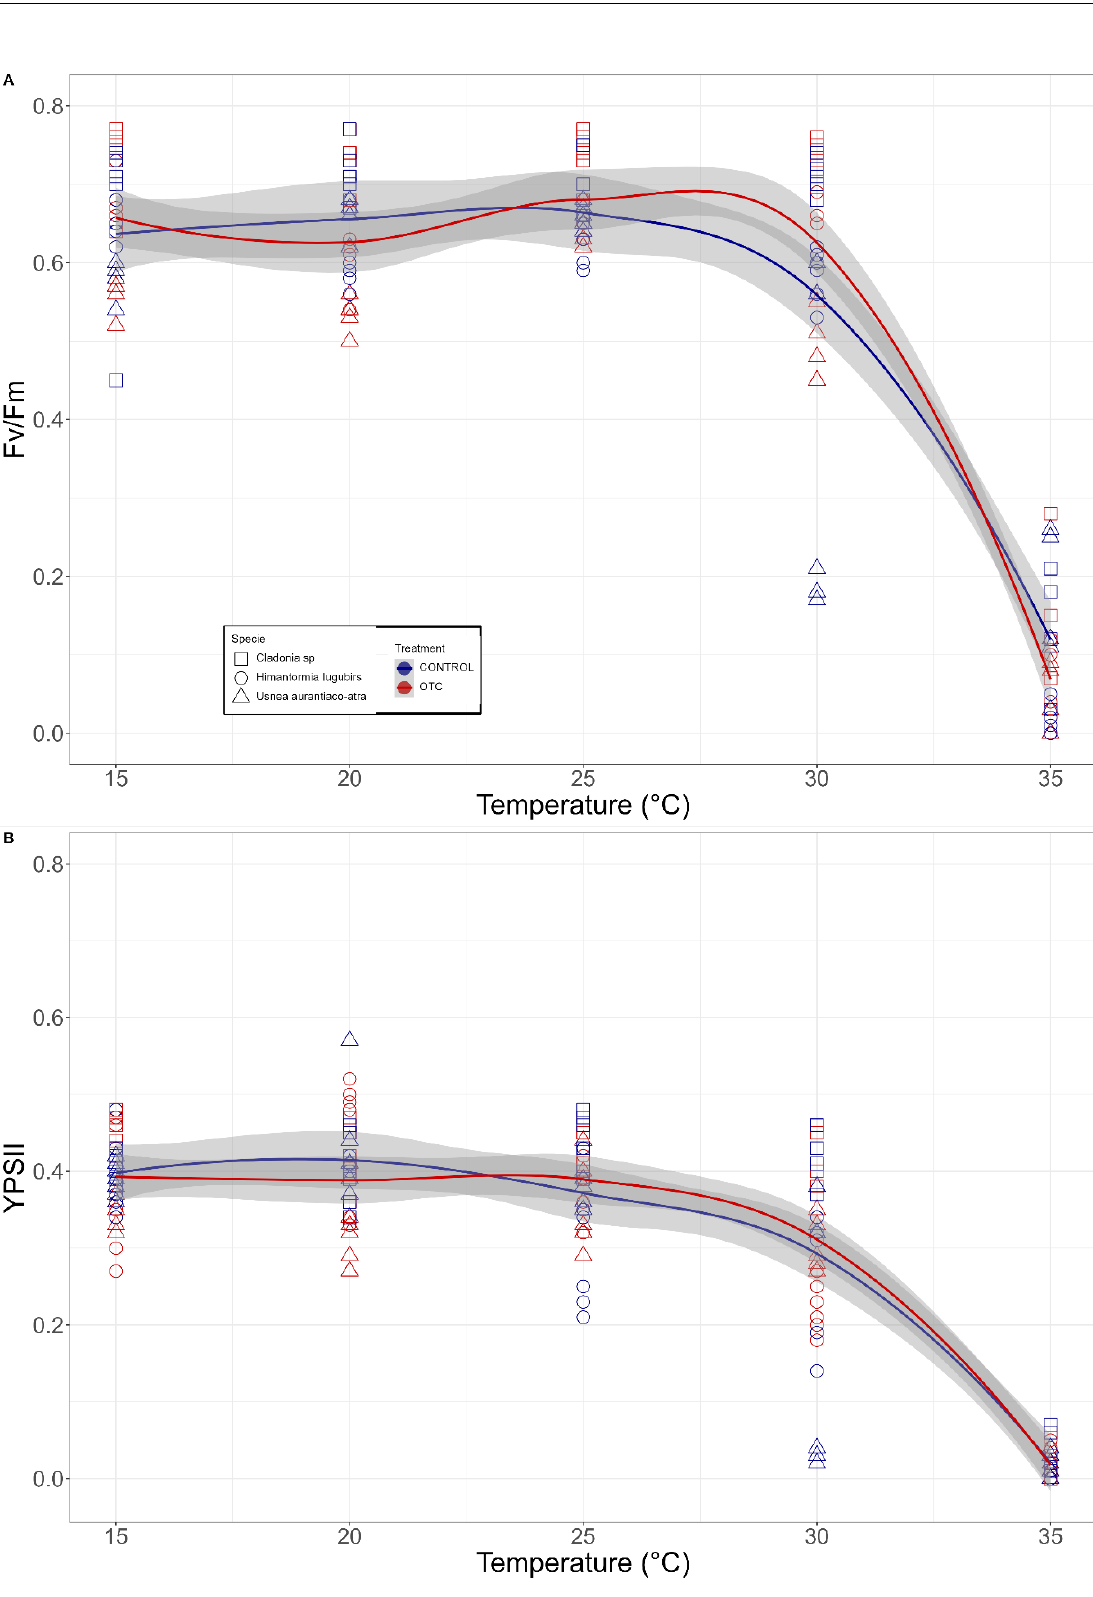
Figure 5. Changes in ( A ) Fv/Fm and ( B ) YPSII in the lichen thalli treated by one-hour thermal shock (15 °C, 20 °C, 25 °C, 30 °C, and 35 °C). Results for samples exposed to passive warming are colored with red and control with blue; tendency lines correspond to local polynomial regression fitting and gray area indicates the standard error of the tendency lines using t-based approximation; n = 6 for each temperature and lichen species.